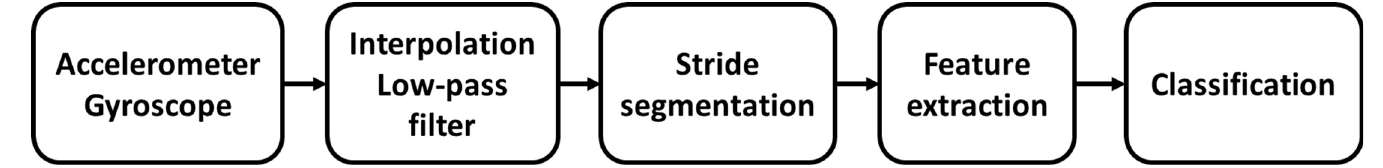
Fig 2. General workflow of the machine learning system from [31]. Figure adapted from the original source.